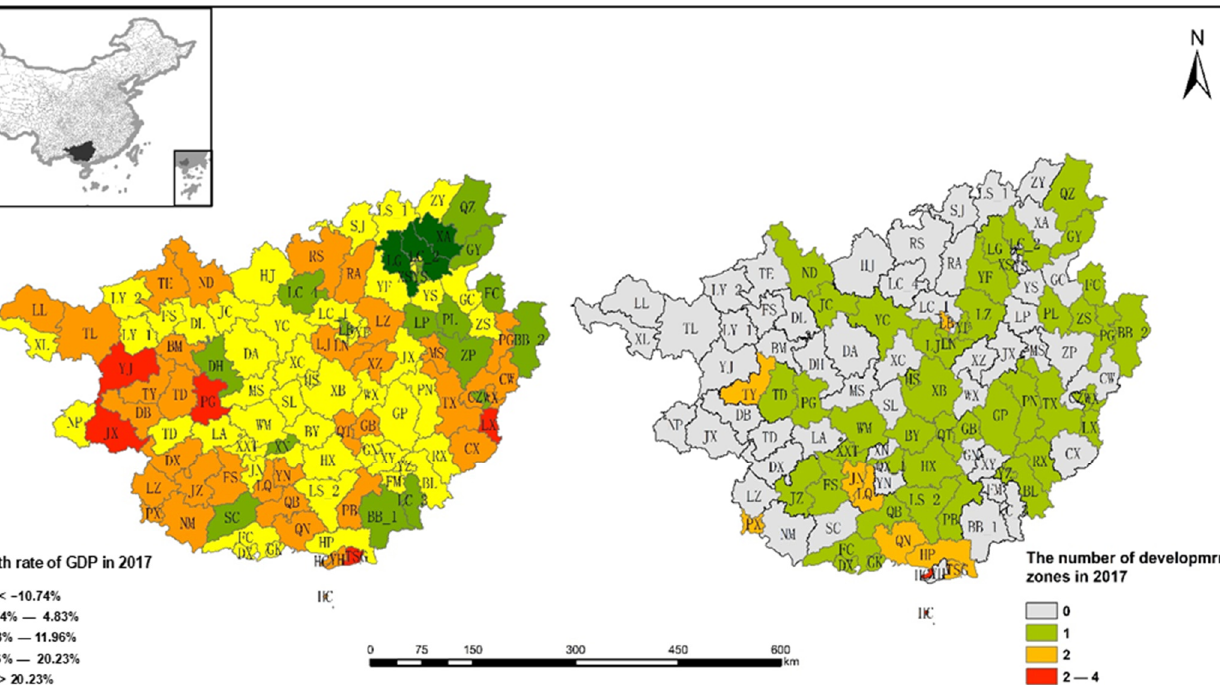
Figure 2. Study area: the growth rate of GDP and the number of development zones in Guangxi.